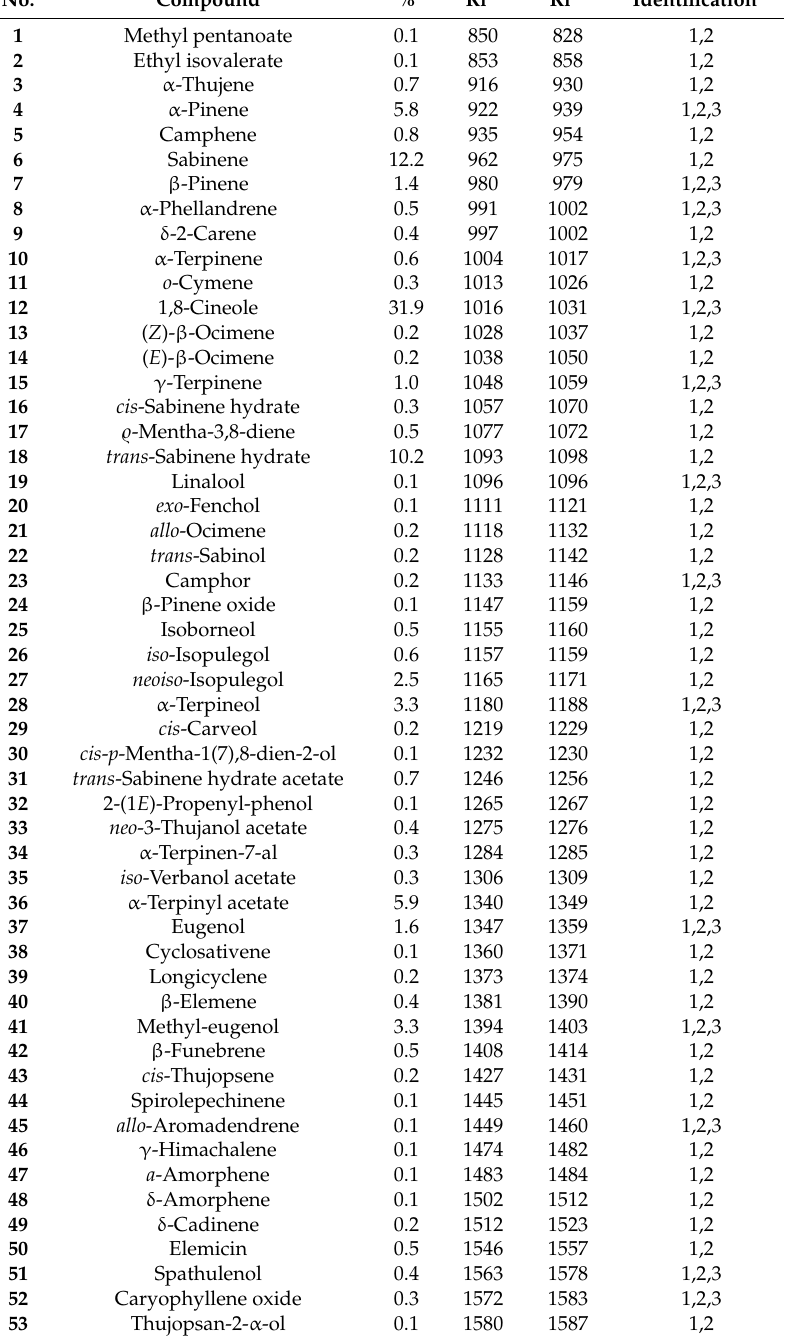
Table 1. Chemical composition of the essential oil (EO) isolated from the leaves of L. nobilis.